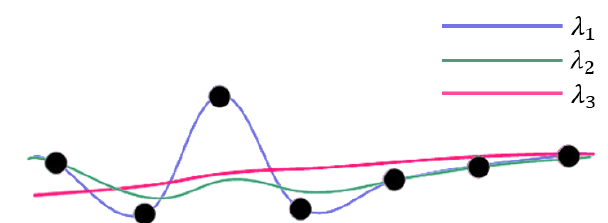
Figure 7. Surfaces using different λ fitting the same seed points. 𝜆 1 < 𝜆 2 < 𝜆 3 and 𝜆 1 = 0 .